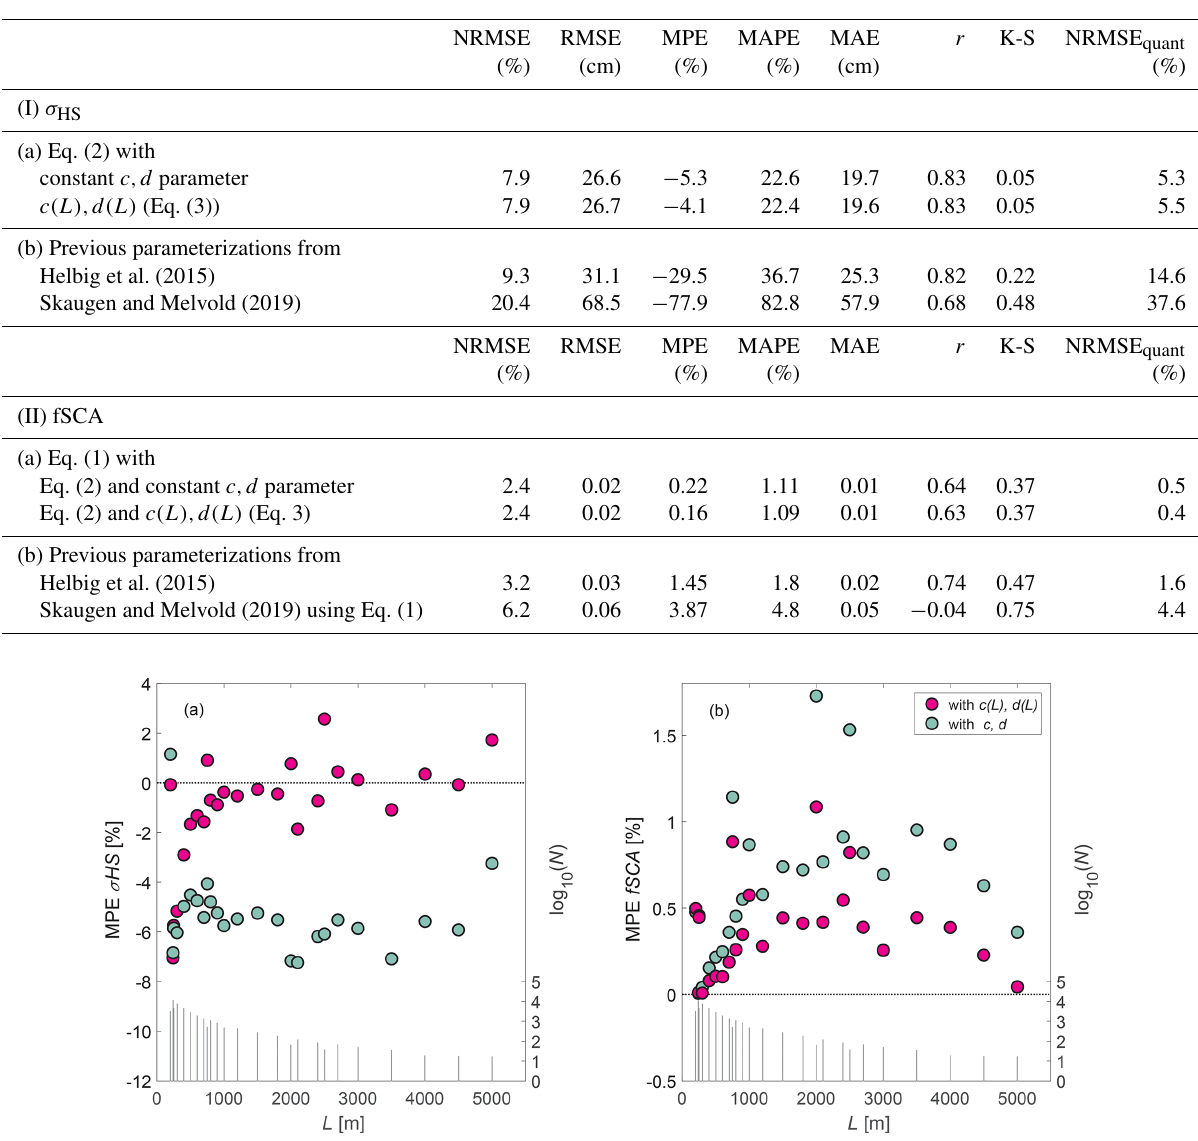
Table 1. Performance measures for all L values between measurement and parameterization of (I) standard deviation of snow depth σ HS with (a) Eq. (2) and constant or L -dependent fit parameters c,d (Eq. 3) and (b) σ HS as in Helbig et al. (2015) and Skaugen and Melvold (2019) and of (II) fSCA with (a) Eq. (1) and (1a) and (b) fSCA as in Helbig et al. (2015) and Skaugen and Melvold (2019) using Eq. (1).